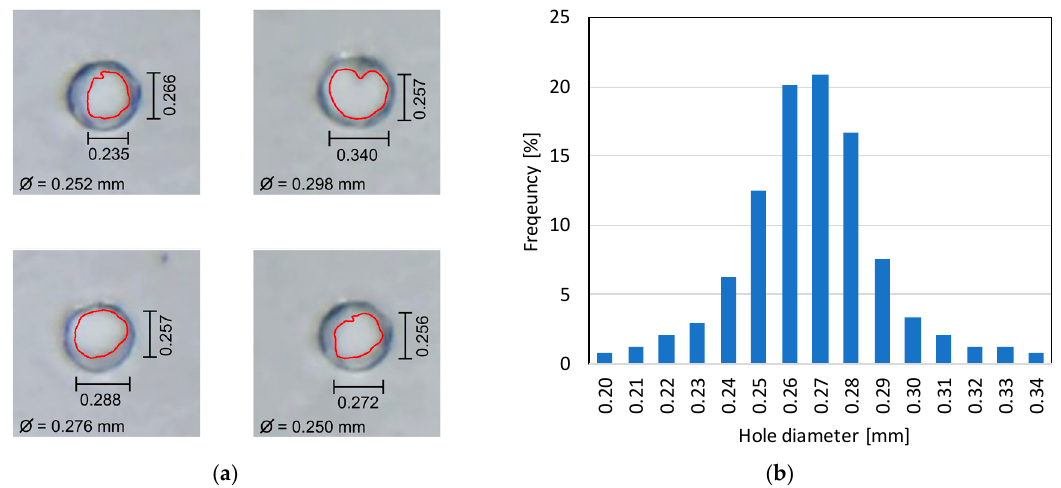
Figure 2. ( a ) Magnified image of a sample of the holes of the micro-perforated panels with major dimensions and effective diameter (in mm). Red line highlights the hole perimeter obtained by means of the segmentation algorithm; and, ( b ) Frequency distribution of effective hole diameters. Table 2. Configurations of multi-leaf resonant absorbers used in the preliminary test. Panel Arrangement: From the Structure Surface to the Identifier